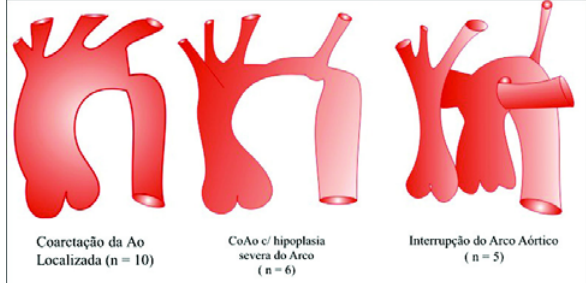
Fig.1 - TGA + obstrução do arco aórtico - anatomia do arco aórtico